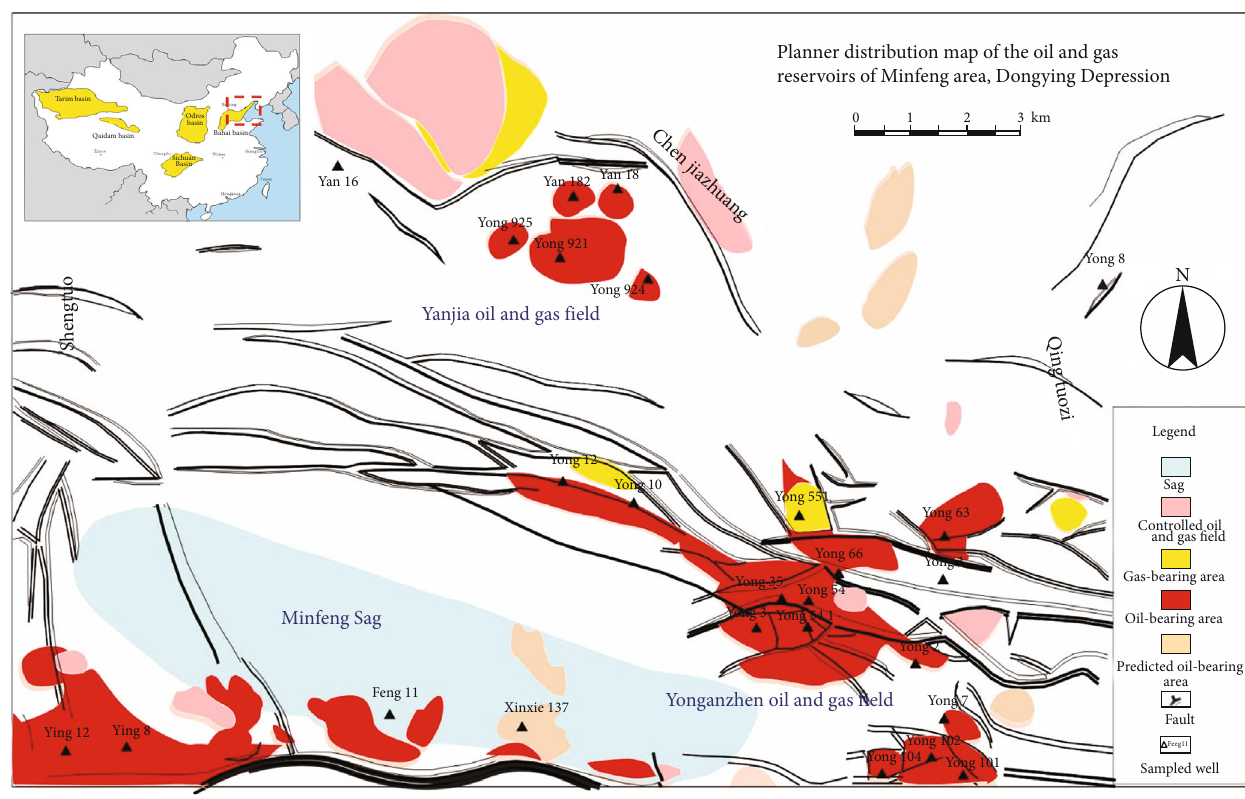
Figure 1: Map of the main sedimentary basins of China and hydrocarbon distribution in Minfeng area, Dongying Depression. On the upper map, the yellow is the sedimentary basin. In the lower map, the grey is the subsag; red represents the oil-bearing area and yellow represents the gas-bearing area. Table 1: Crude oil geochemical characteristics of four types.